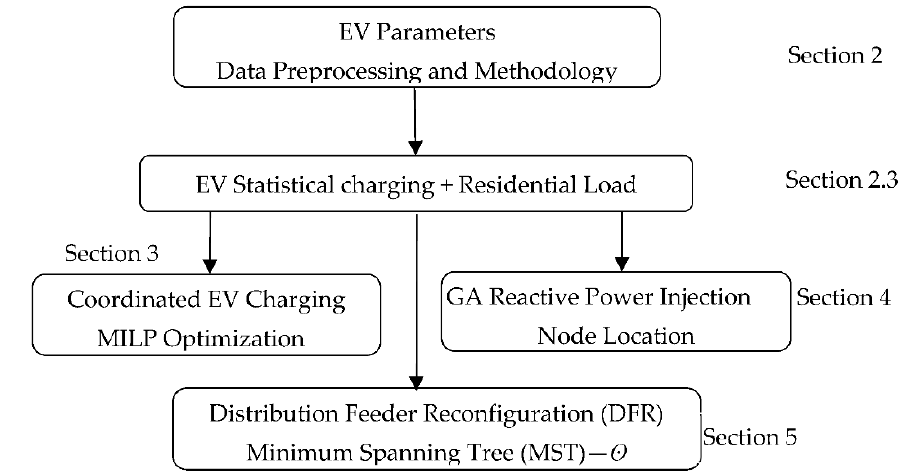
Figure 2. Numerical Computation Analysis flow chart .